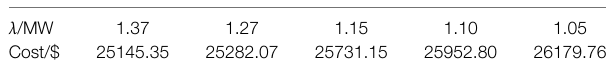
TABLE 2 | Cost comparison under different constraint values of average peak-valley difference.